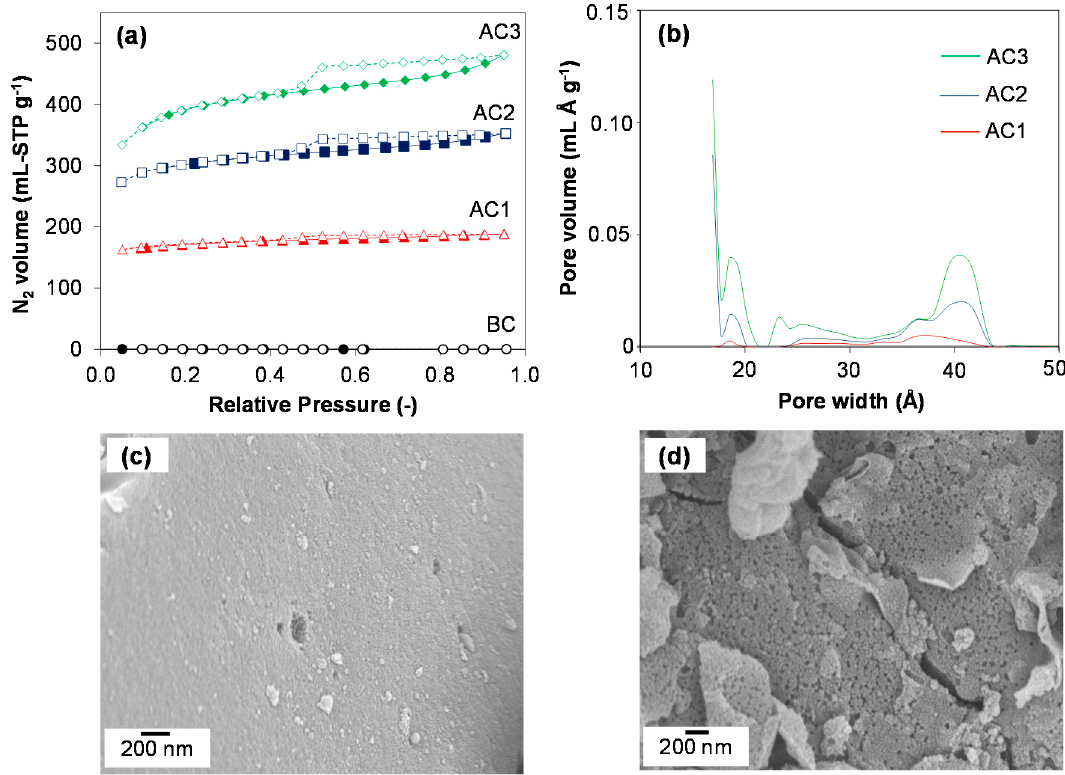
Figure 3. Properties of biochar and activated carbon samples: ( a ) N 2 adsorption-desorption isotherms at − 196 °C (closed and open symbols correspond to adsorption and desorption points, respectively); ( b ) NLDFT pore size distributions; ( c ) FESEM image of BC and ( d ) FESEM image of AC3. Table 1. Yields and porous characteristics of samples.